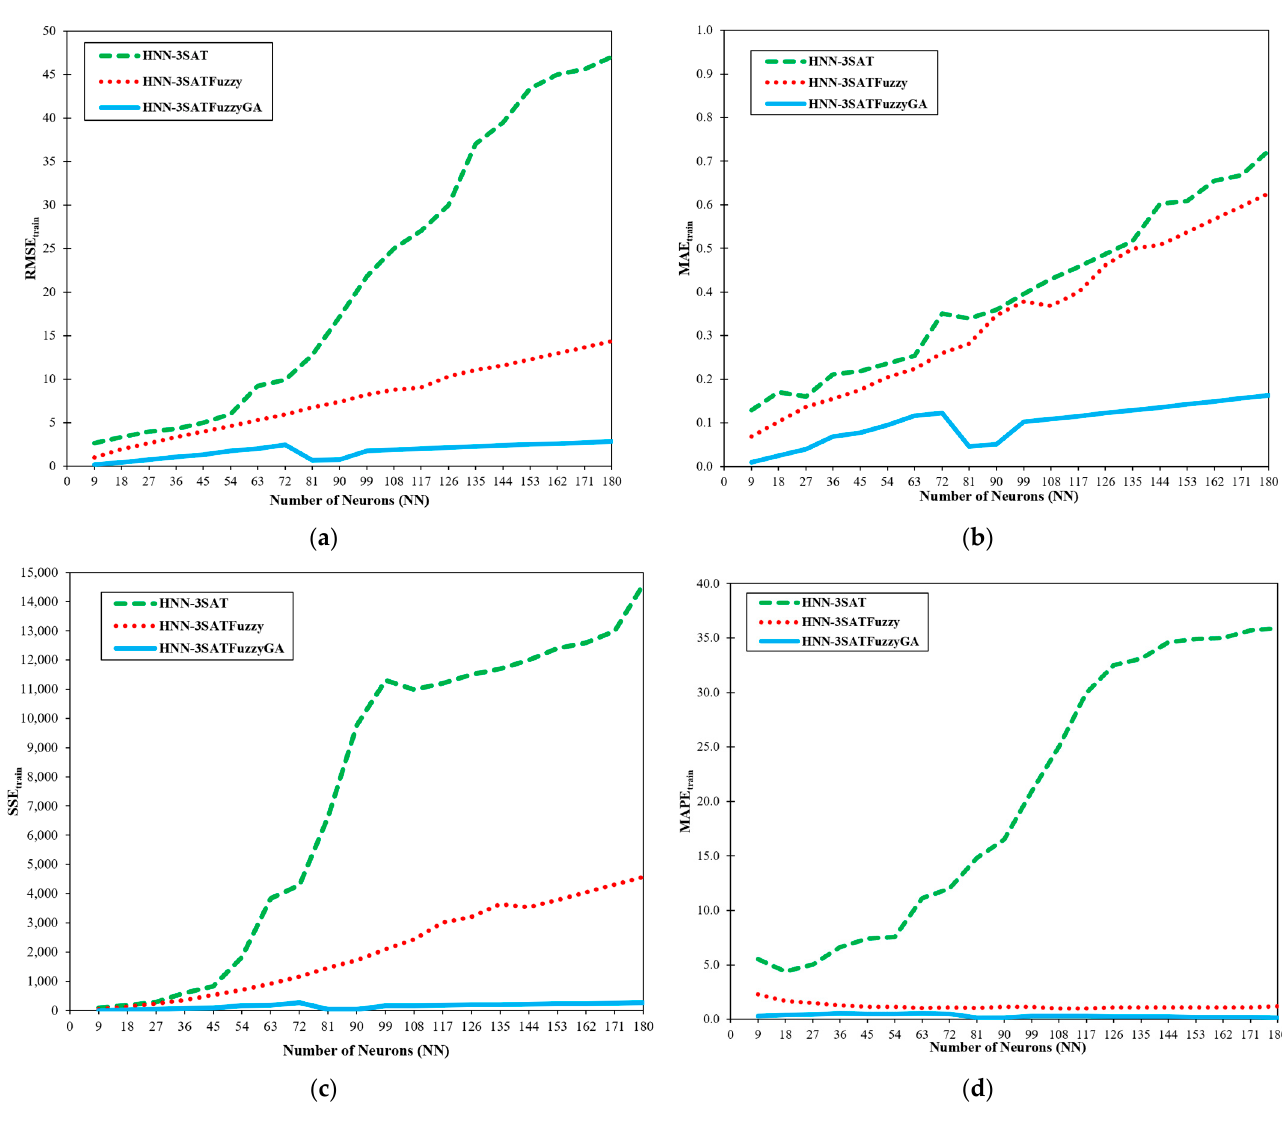
Figure 3. The error analysis metrics in the training phase ( a ) RMSE train ; ( b ) MAE train ; ( c ) SSE train ; ( d ) MAPE train